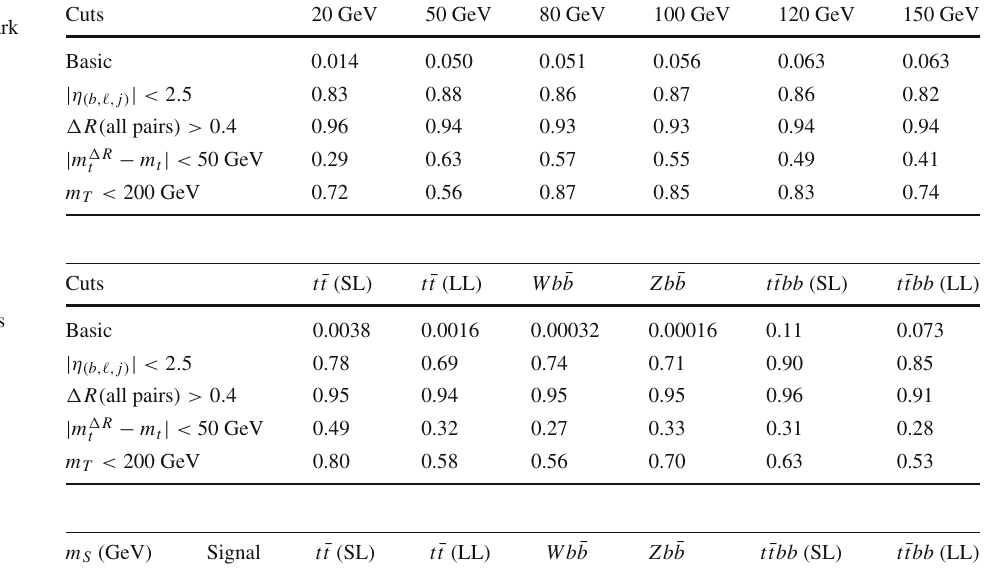
Table 4 Efficiencies ( × 10 4 )